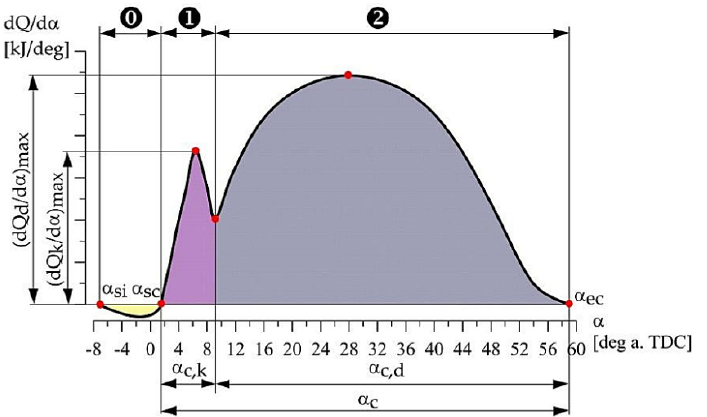
Figure 9. Characteristics of the heat release rate in a compression ignition engine divided into kinetic and diffusion combustion, where [46]: 0—auto-ignition delay period, 1—kinetic combustion, 2—diffusion combustion.